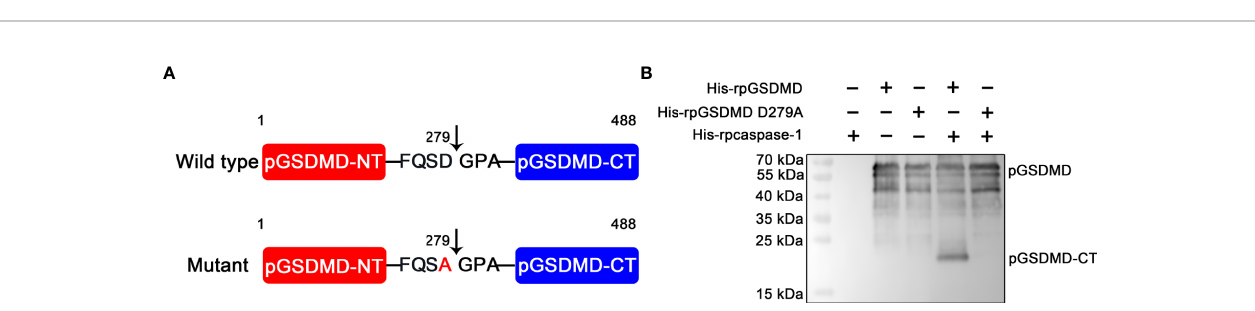
FIGURE 5 | D279A mutation abolished the cleavage of His-rpGSDMD by His-rpcaspase-1. (A) The diagram of deduced cleavage site of pcaspase-1 in pGSDMD. The D279 was replaced with an alanine in the His-rpGSDMD D279A mutant. (B) His-rpGSDMD D279A and His-rpGSDMD were incubated with His-rpcaspase-1, respectively. The products were analyzed by Western blot analysis using mouse anti-rpGSDMD